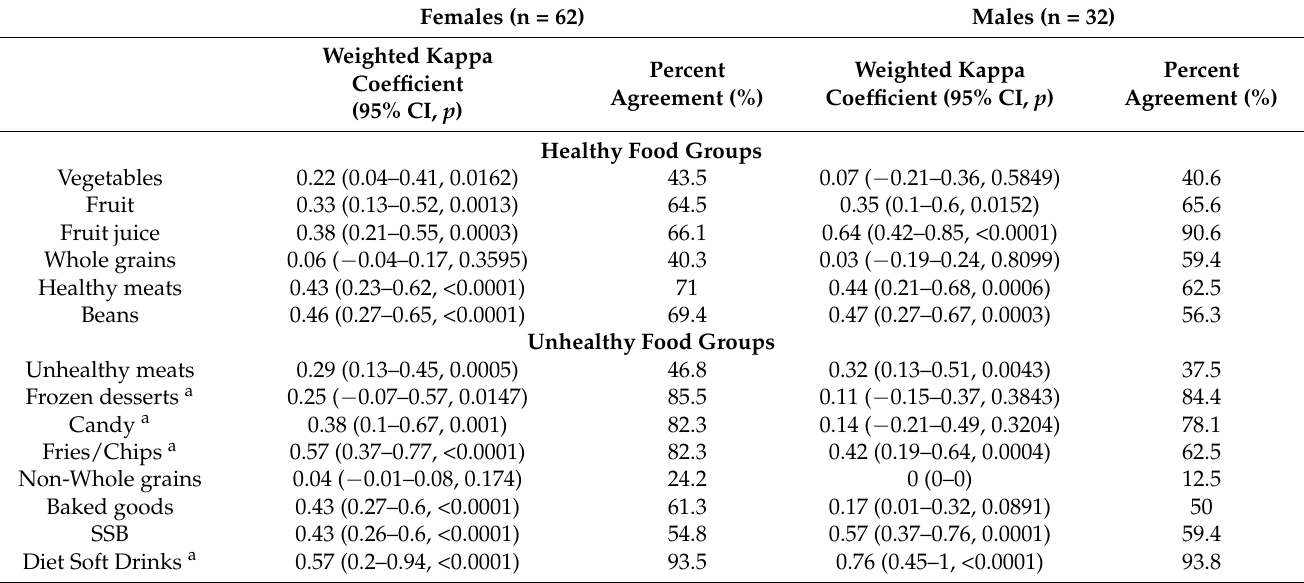
Table 5. Comparison of SPAN MAA and 24 h recall, by sex (n = 94).